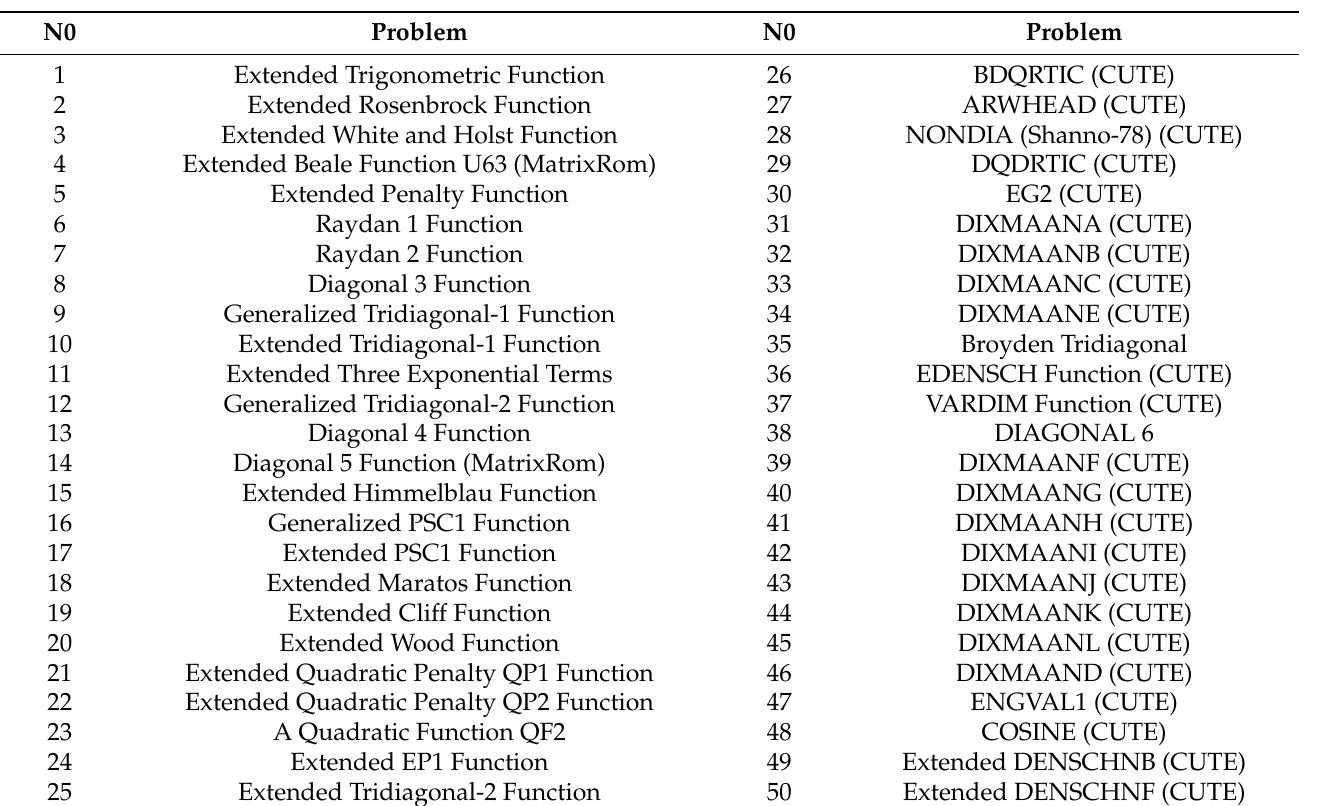
Table 1. The testing